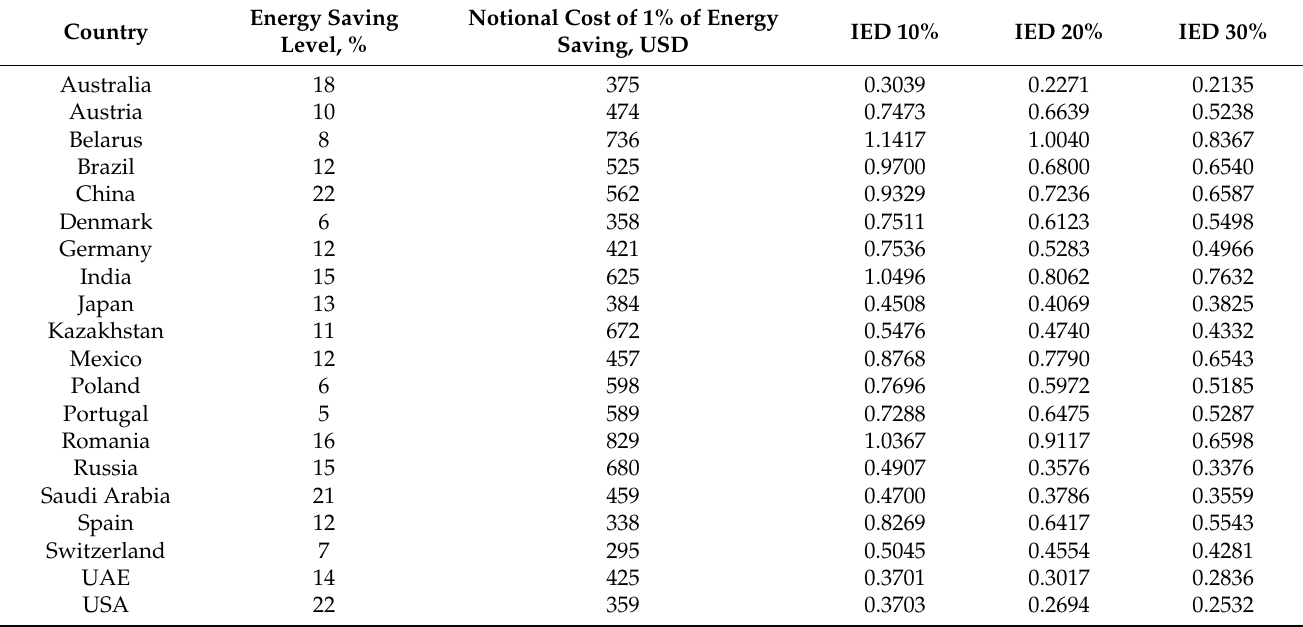
Table 1. Initial data for determining the risk limit of the level of energy autonomy of